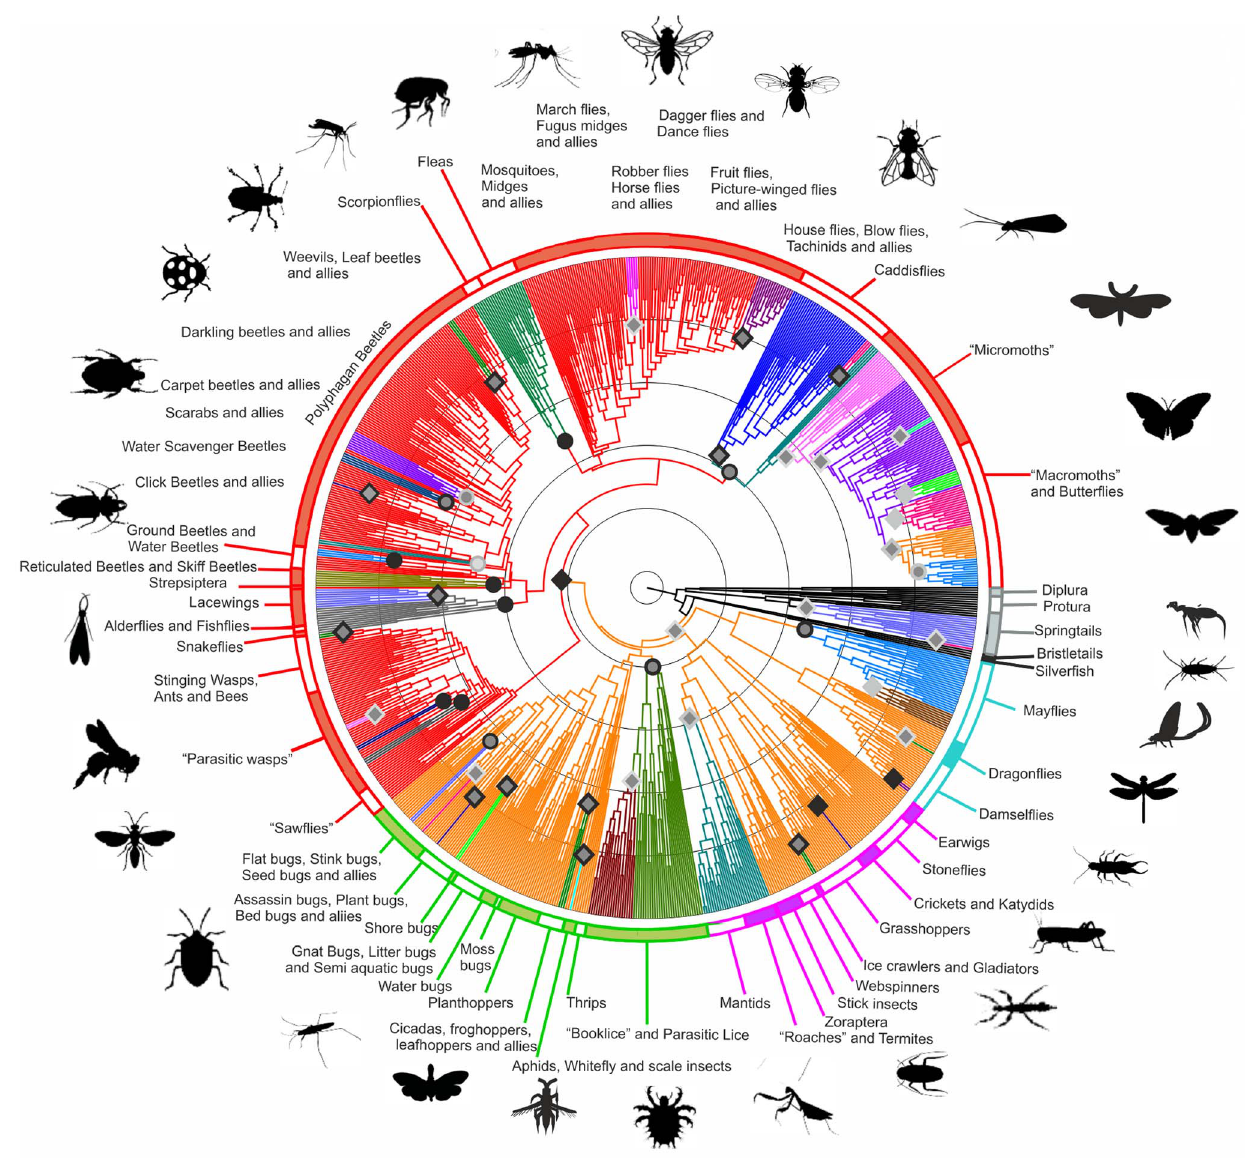
Figure 1. Dated phylogeny of extant hexapod families showing diversification rate shifts. The tree shown is from a maximum likelihood analysis of 8 genes, calibrated by 89 fossils. Membership of major clades is denoted by coloration of the ring (grey: Entognatha, black: basal insects, cyan: Palaeoptera, magenta: Polyneoptera, green: Paraneoptera, red: Holometabola). Changes in branch coloration denote diversification shifts identified using TurboMEDUSA (Table S3). Branch colors identify regions of the tree with the same underlying diversification model. Symbols at shifts denote a net upshift (diamond) or down shift (circle). Coloration of symbols reflects the robustness of the shift event across 500-scaled samples taken from the post-burin MCMC chain (black: shift recovered in . 80% of samples, grey with black outline: recovery . 50%, grey with pale outline: recovery . 30%, pale grey: recovery , 30%). Black rings are shown at 100 Ma increments from the present. See Supplementary materials for further details and discussion. See also Figures S1–S3, Tables S1–S4, and Datafiles S1, S2.